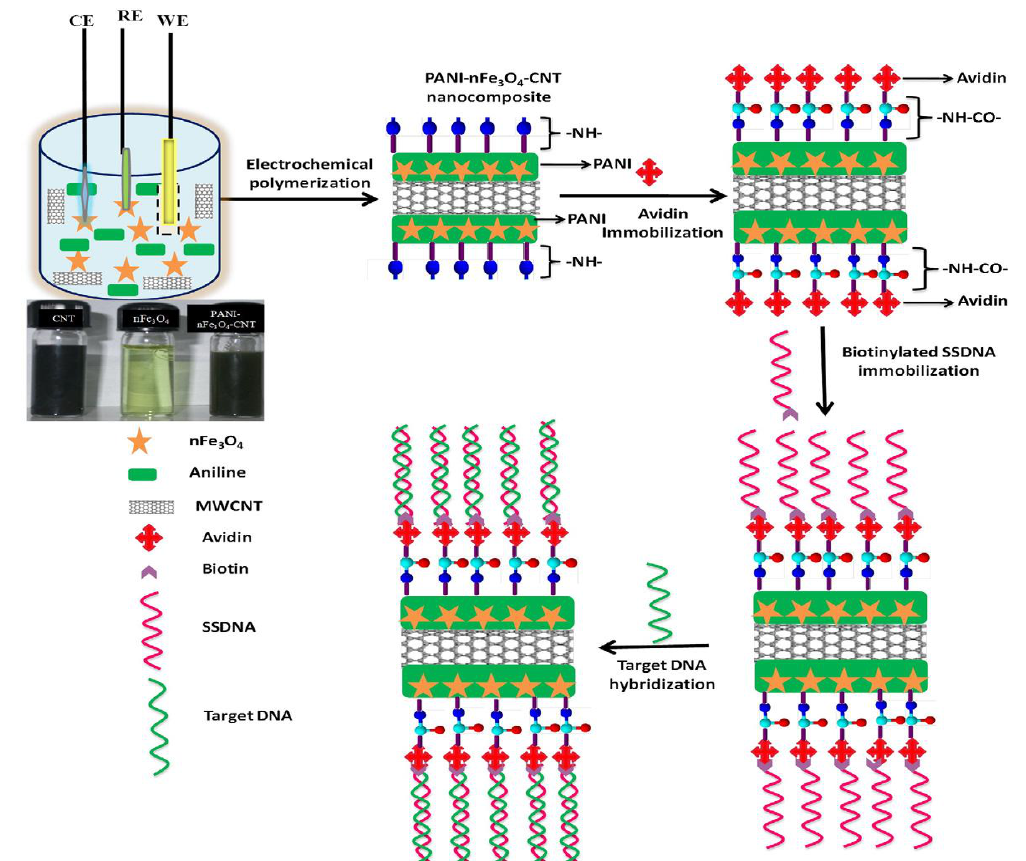
Figure 8. Preparation of PANI-nFe biotinylated DNA using biotin-avidin coupling followed by hybridization for bacterial detection. Reprinted with permission from [53], © 2012